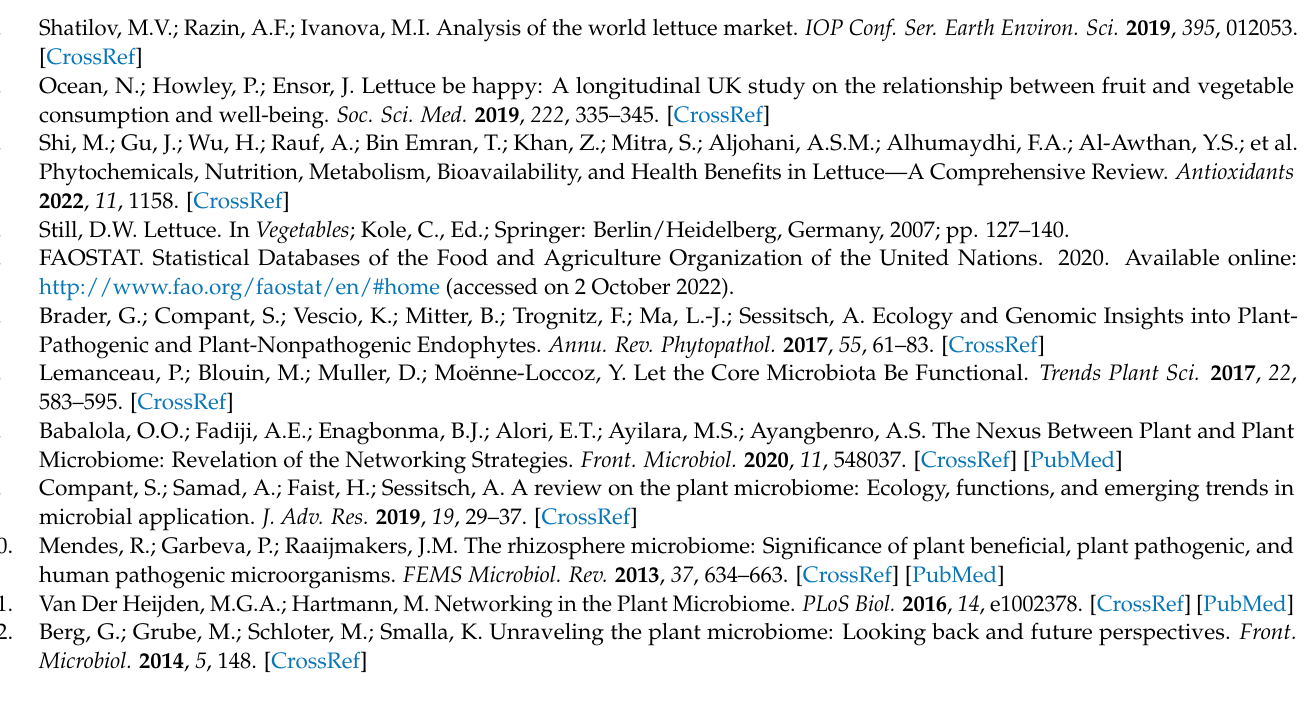
Table S6. One-way ANOVA comparison of alpha diversity indices of fungal microbiome in root and rhizosphere of six varieties of lettuce under normal conditions and salinity stress. Table S7. Changes of genera abundance in fungal community in rhizosphere of six varieties of lettuce under salinity stress. Only genera significantly changed in at least single variety are listed. Values are two-fold logs, ** p < 0.01, * p <